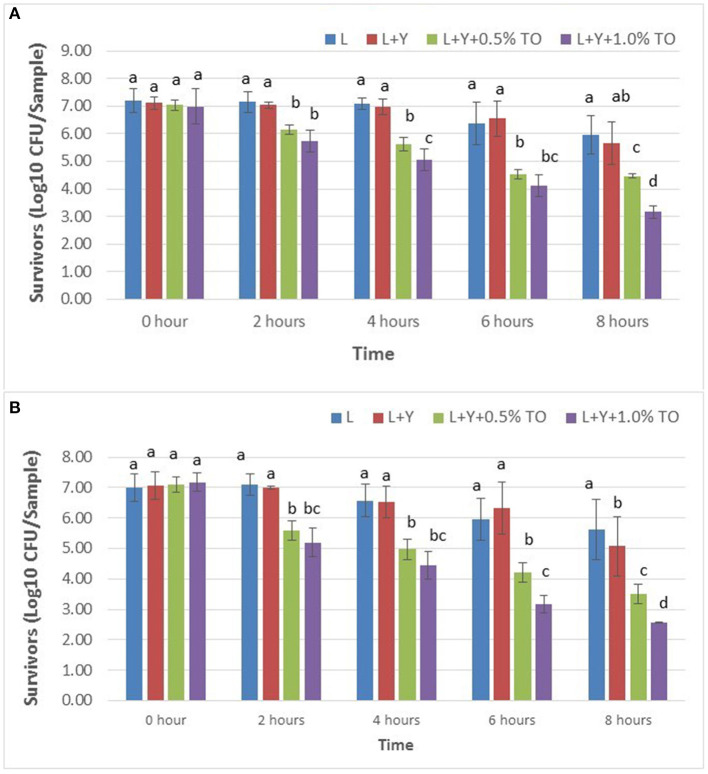
Survivors of Salmonella enterica attached to raw chicken breast meat in lemon juice marinades based on bacterial colony counts on TAL medium (A) and on XLT4 agar (B).